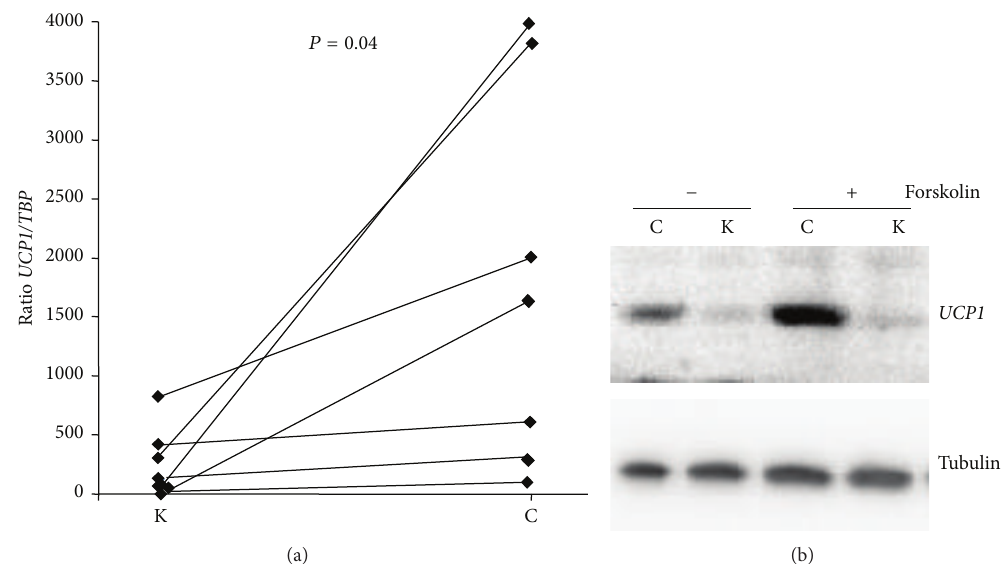
Figure 5: UCP1 expression in adipocytes generated from chin ASCs. ASCs derived from chin (C) and knee (K) were induced to undergo differentiation for 10 days. (a) RNAs were prepared and UCP1 expression was determined by real-time PCR. 𝑛 = 7 paired depots. Corresponding data points of knee and chin paired depots are connected with lines. (b) Cells were stimulated (+) or not ( − ) with forskolin for 4h and then proteins were prepared. Expression of UCP1 was assessed by Western-blotting. Tubulin was used as loading